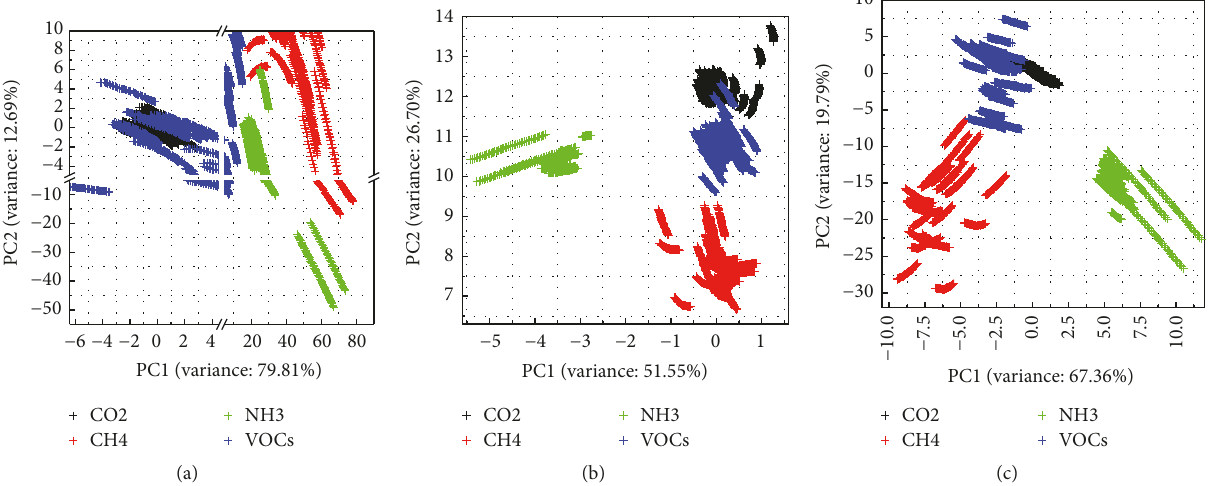
Figure 3: Classification results of steady-state PCA, steady-state LDA, and steady-state PCA + LDA method before the feature extraction corresponding to (a), (b), and (c), respectively. The horizontal axis represents the proportion of the first variance (eigenvalues corresponding to the eigenvalues), and the vertical axis represents the proportion of the second variance, and the two constitute the original classification in the two-dimensional distribution space.